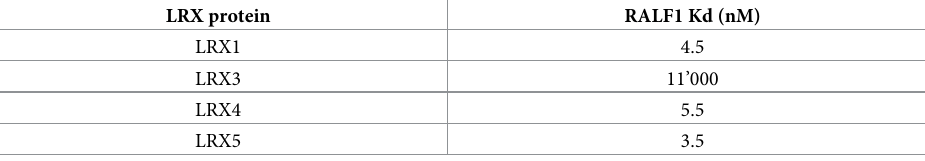
Table 1. Dissociation constant of LRXs-RALF1 interactions.